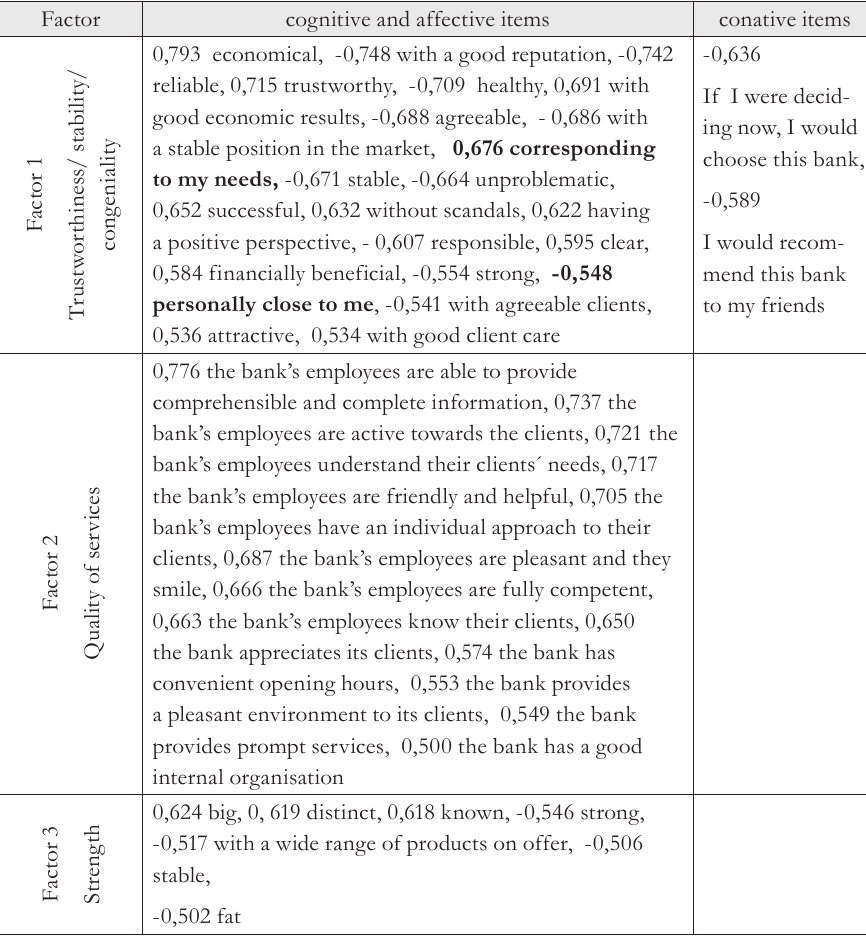
Tab. 5 - Bank 1: A description of the content of the extracted factors (a list of items and their polarities). Source: